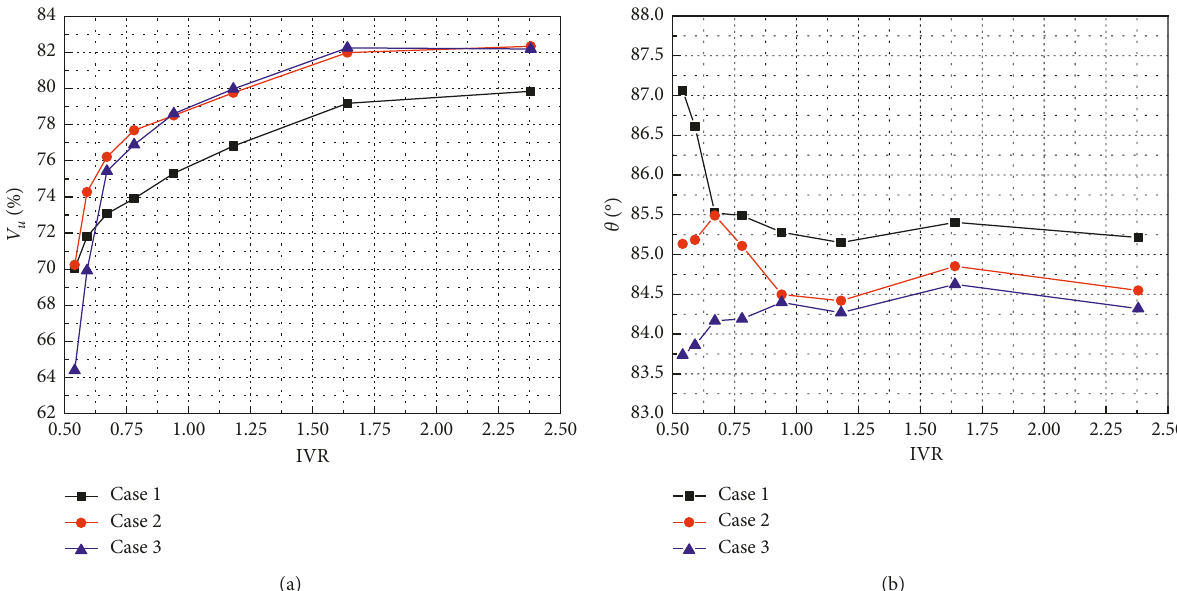
Figure 19: Hydraulic characteristics of inlet passage outlet with different inlet passage lengths. (a) Axial velocity distribution coefficient V (b) Weighted-velocity average swirl angle θ .